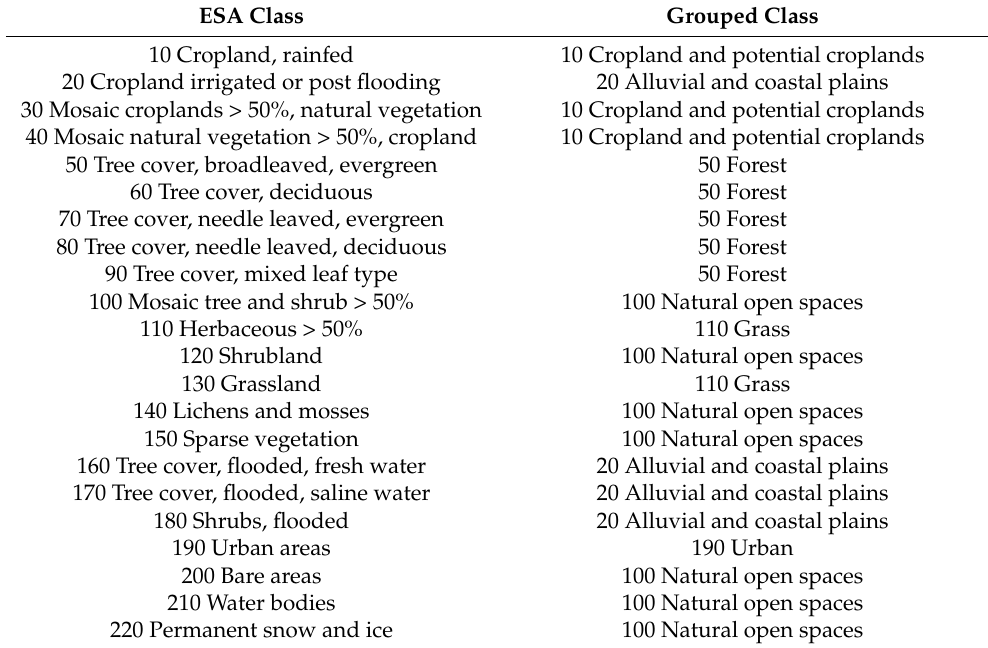
Table A2. Classification of ESA land use